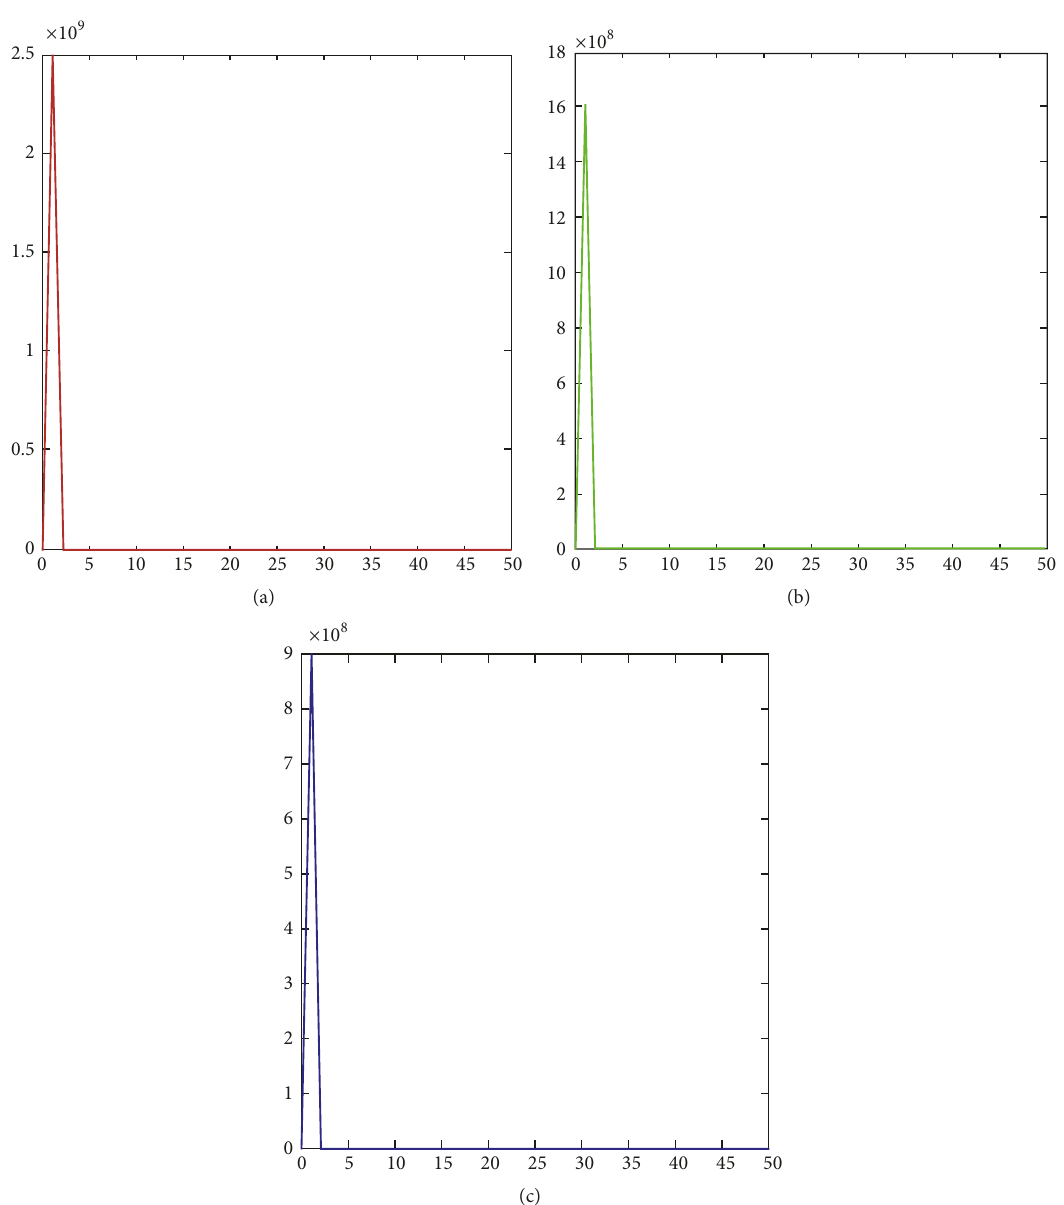
Figure 12: Corresponding convergence for error estimation in function of the iterations, where the simulated time is 𝑡 = 50 : (a) for 𝑃 (b) for 𝑍 , and (c) for 𝐹